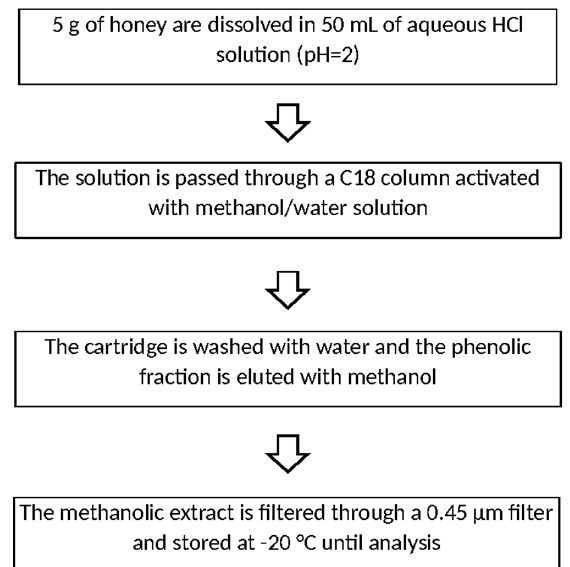
Figure 5. Extraction/clean-up of phenolic compounds from honey on C18 cartridge, according [51].